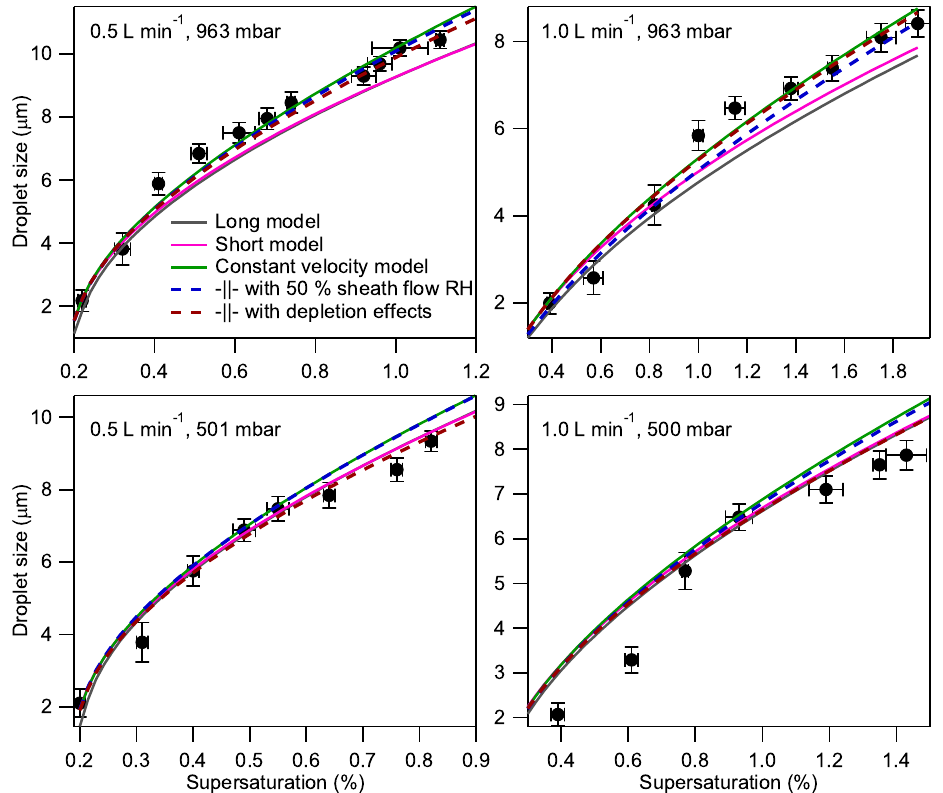
Fig. 6. Observed and predicted droplet size for 90nm ammonium sulfate particles. Constant water uptake coefficient of 0.2 is assumed for all model versions. The experimental data is same as in Fig.